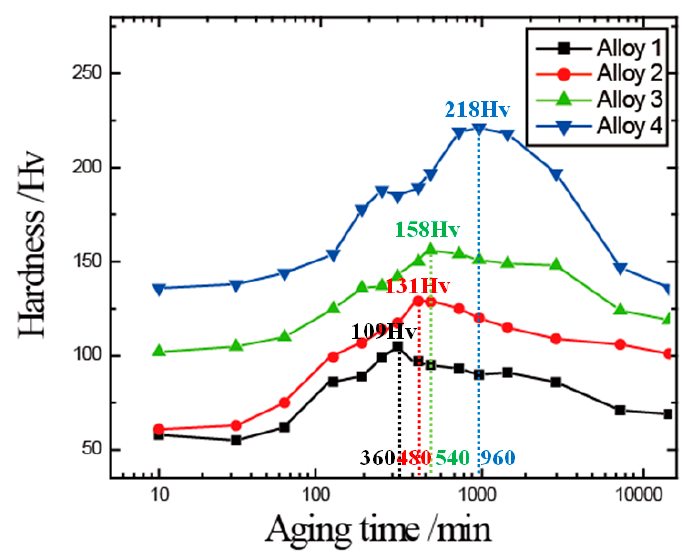
Figure 9. Hardness versus aging time at 165 °C of Al-Mg-Si alloys with different Cu contents.